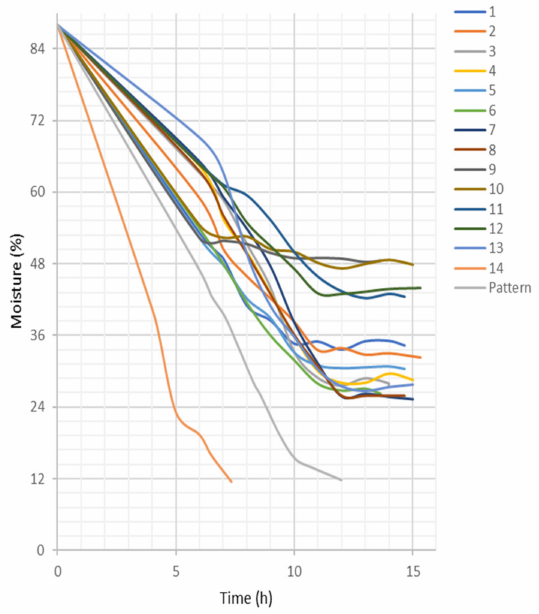
Figure 9. Curves moisture vs.